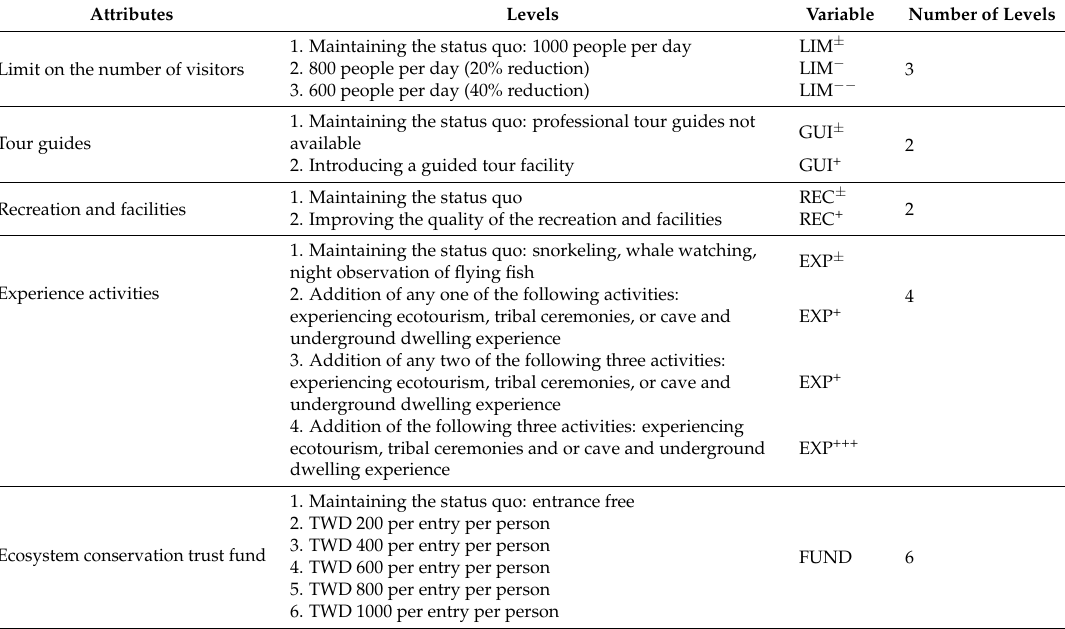
Table 1. Attributes and levels of attributes of the Orchid Island tourism